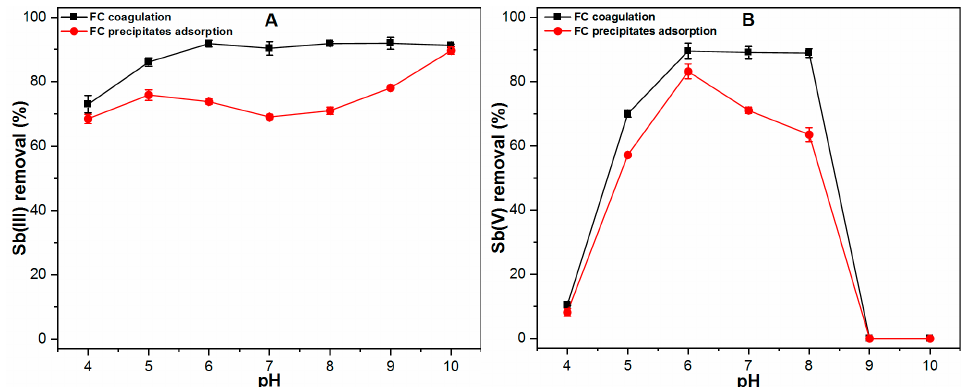
Figure 2. Comparison of ( A ) Sb(III) and; ( B ) Sb(V) removal via FC coagulation and adsorption onto preformed FC precipitates across a wide pH range (4–10).